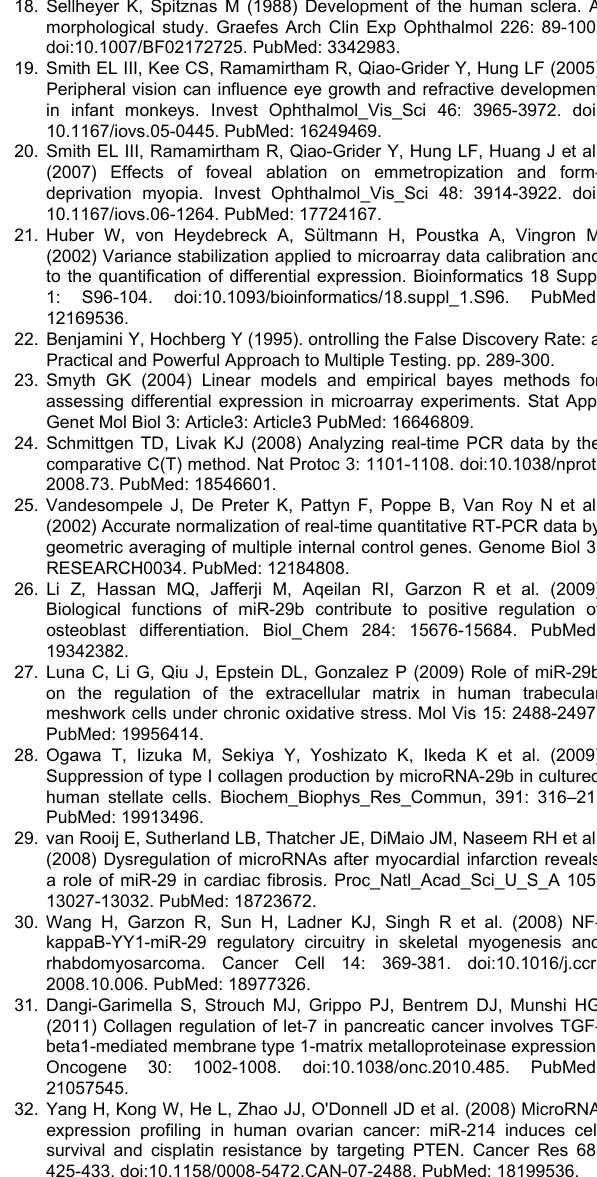
Table S1. micro-RNA predictions for Col1a1. (XLS) Table S2. Summarized values.